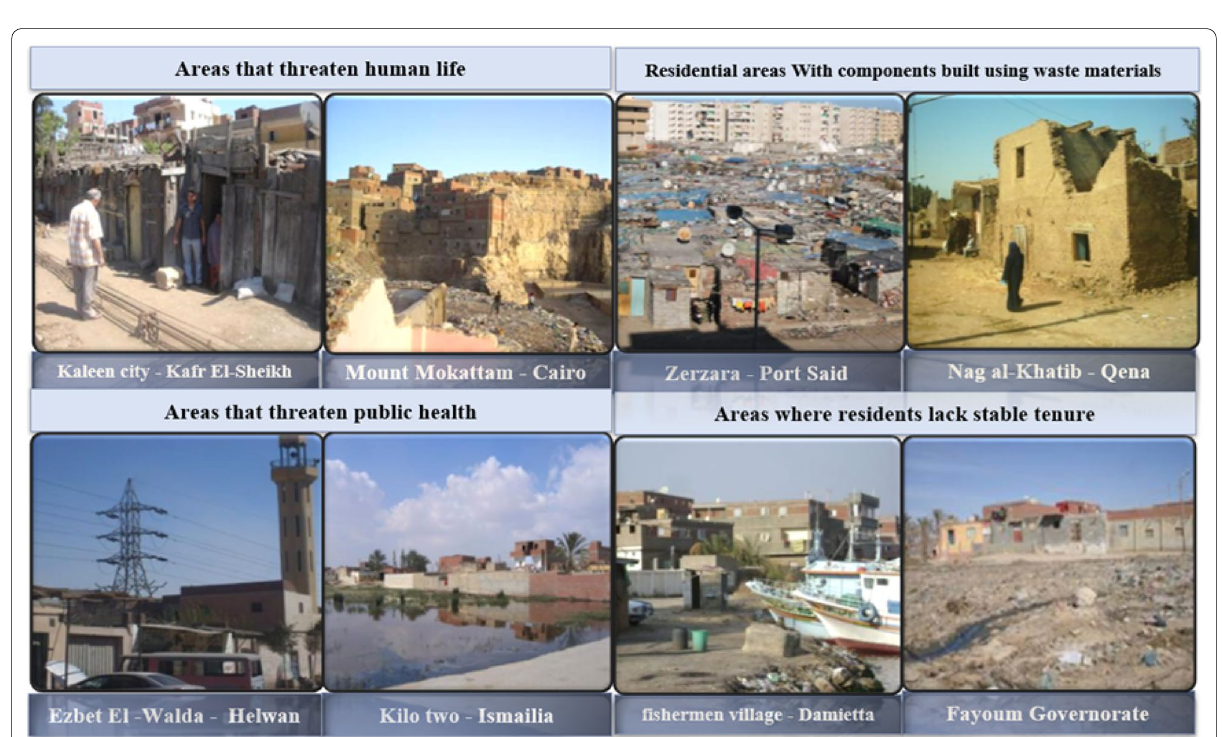
Fig. 2 classification of slums ( Source: Presidency of the Council of Ministers Slums Development